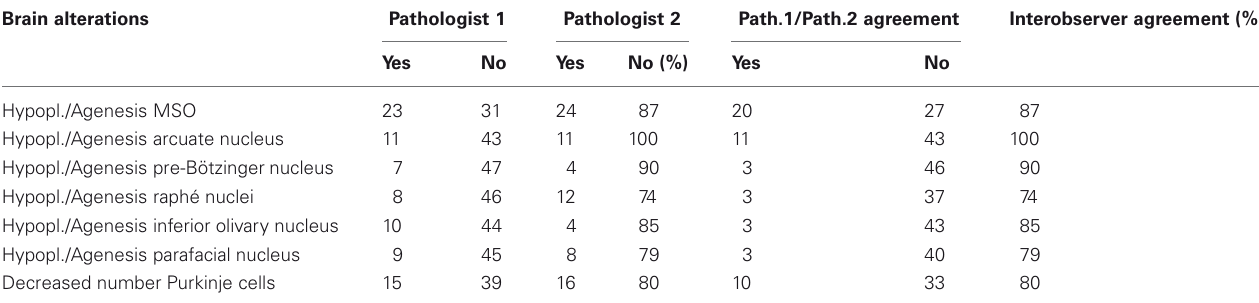
Table 1 | Results of the brain microscopic examinations carried out by two pathologists (1 and 2) in 54 victims of sudden unexplained death and interobserver agreement percentage (mean value: